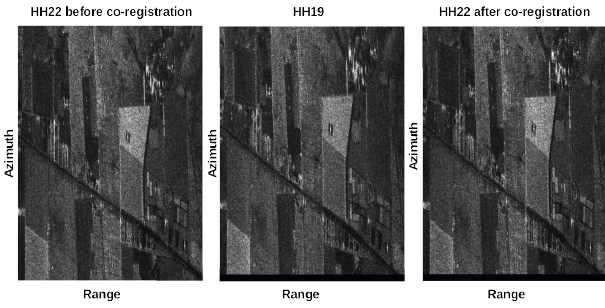
Figure 5. SLC amplitude images (HH polarization) relevant to the tracks 19 and 22 before (left panel) and after (right panel) applying the co-registration algorithm.